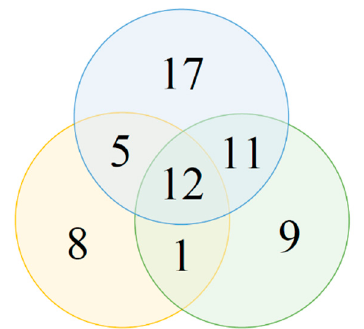
Figure 6. Venn diagram displaying numbers of strains within the “induced” group that were PHA positive on different versions of PIM. Blue circle—PIM1, green circle—PIM2, orange circle—PIM3. Strains were grouped according to the type of environment they were isolated from (Figure 7). Glacial environments harbored the most PHA-positive strains (91%), 52% of which were constitutive granule accumulators. High contribution values of PHA positive strains were also apparent for soil-associated (pedogenic) habitats (78%) but also post-glacial deposits (67%). Marine and animal-influenced habitats contained mostly non-PHA producing strains, albeit the PHA producing minority had to be induced to accumulate PHA ( > 70%). Almost half of the freshwater habitat-isolated strains had PHA synthesis abilities, 67% of which did it without the high carbon to nitrogen ratio induction.